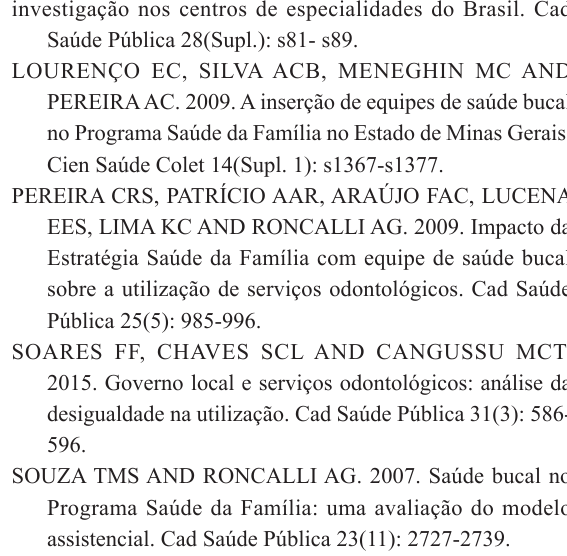
FIGUEIREDO N AND GOES PSA. 2009. Construção da atenção secundária em saúde bucal: um estudo sobre os Centros de Especialidades Odontológicas em